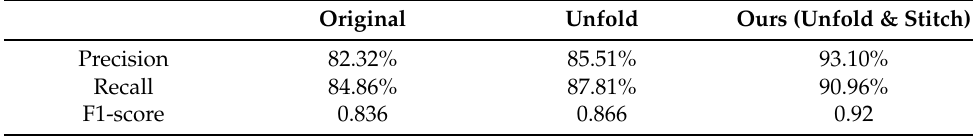
Table 6. Defect detection results of three preprocessing methods.